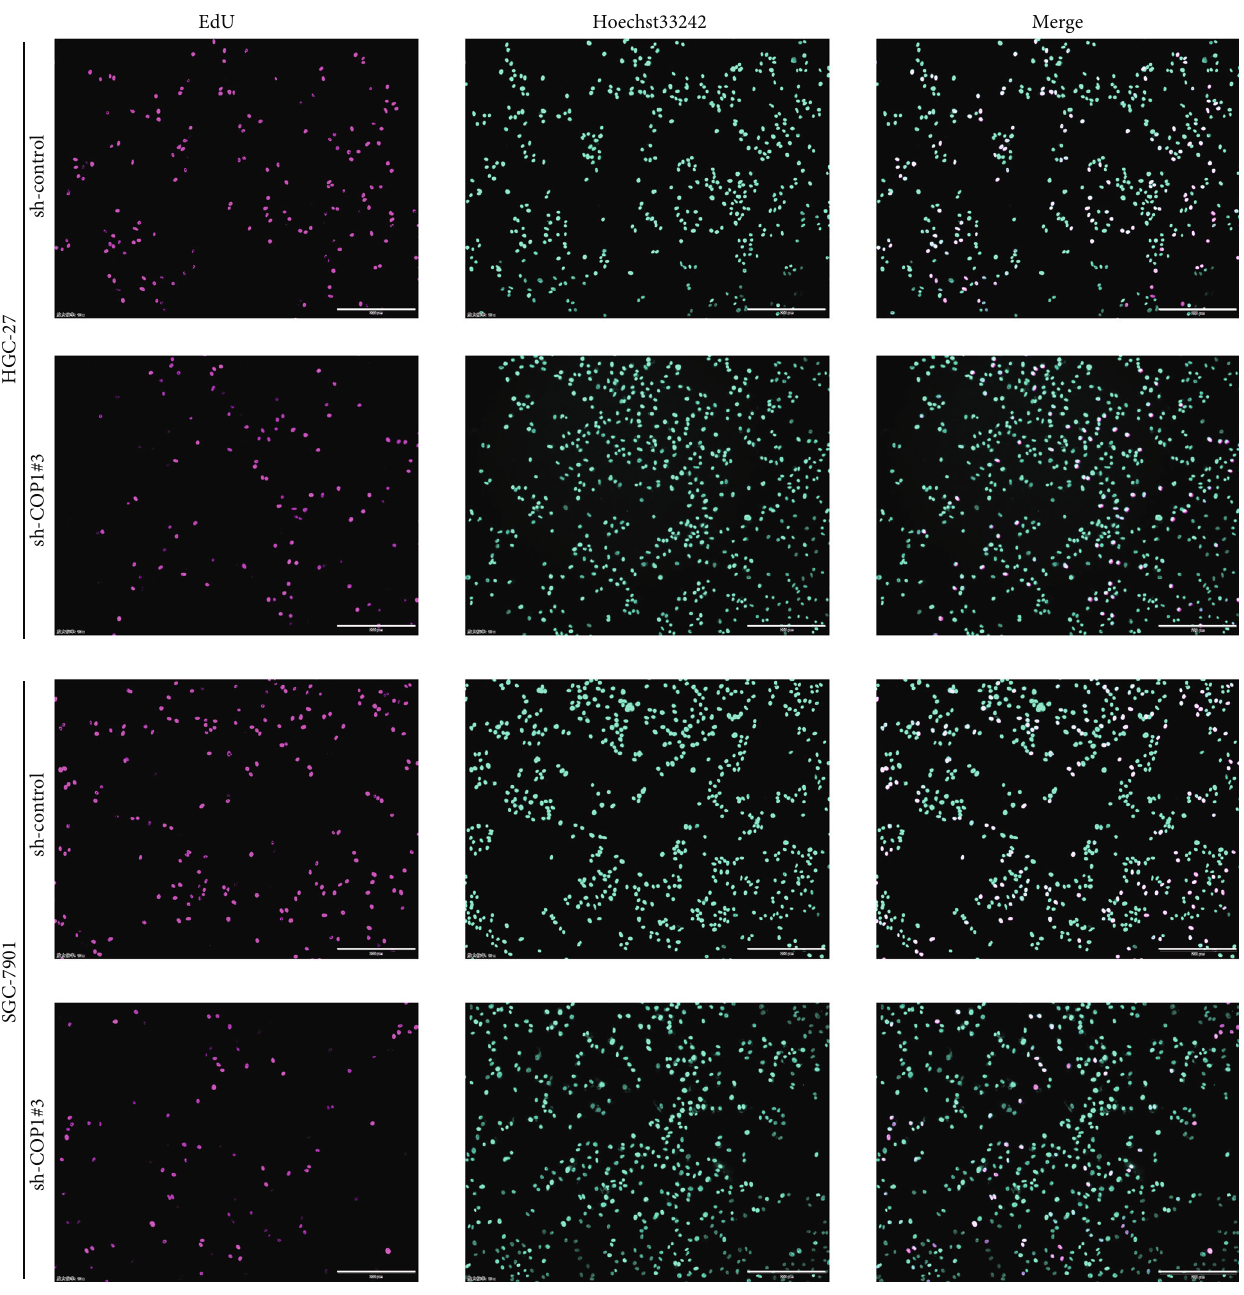
Figure 4: COP1 silencing reduced the vitality of GC cells. (a) WB assay veri fi ed the silencing e ffi ciency in HEK-293T cells; (b) COP1 silencing signi fi cantly reduced the proliferation of GC cells; (c and d) COP1 silencing signi fi cantly decreased the numbers of EdU- positive GC cells. Bar =200 μ m. * P < 0 : 05 , ** P < 0 : 01 , *** P < 0 : 001